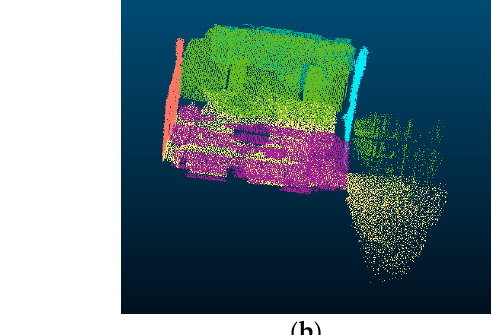
Figure 13. Scenario 1: ( a ) Plane Segments; ( b ) Wall Clusters after the application of the merging logic.